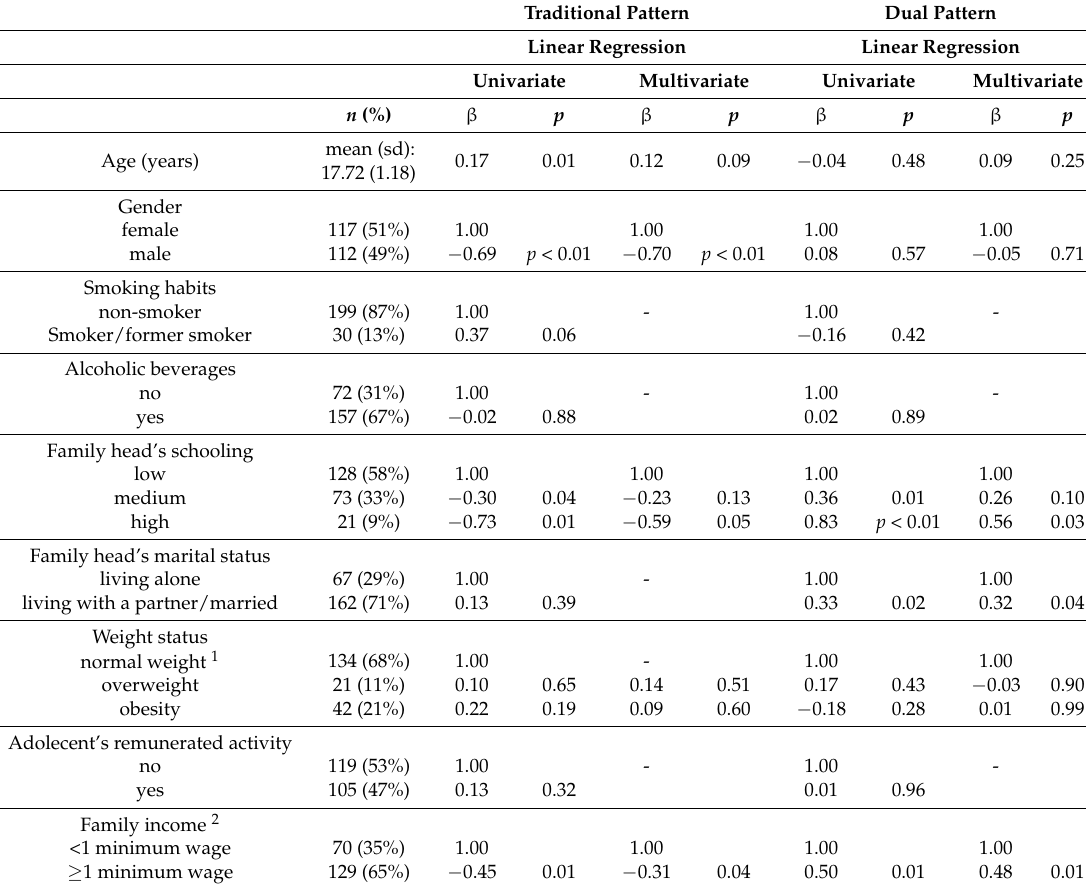
Table 4. Associations between the dietary patterns and the characteristics of the adolescents living in São Paulo. Traditional Pattern Dual Pattern Linear Regression Linear Regression Univariate Multivariate Univariate